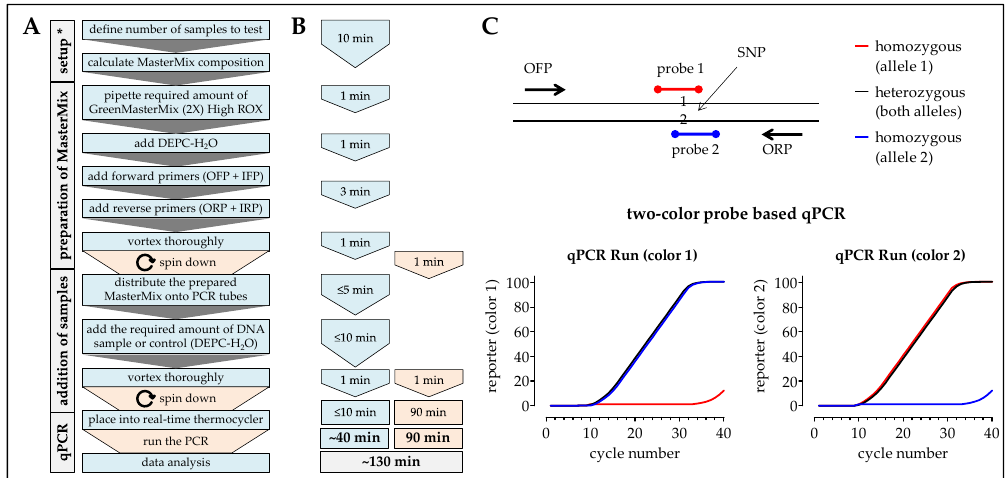
Figure 9. Modification of the ARMS-PCR method using probe based real-time PCR technology—proposed workflow, timing, and expected results. In ( A ) workflow and ( B ) timing the blue color marks handling steps (time) of the experimenter and the orange color marks pause times caused by the procedure. ( C ) Expected results: While the PCR is running a fluorescent signal for both used reporters is detected online. For heterozygous samples both reporters will increase with time. For homozygous samples only one of the reporters will increase with time, depending on the allele present. * When the method is frequently done a calculation matrix should be used.